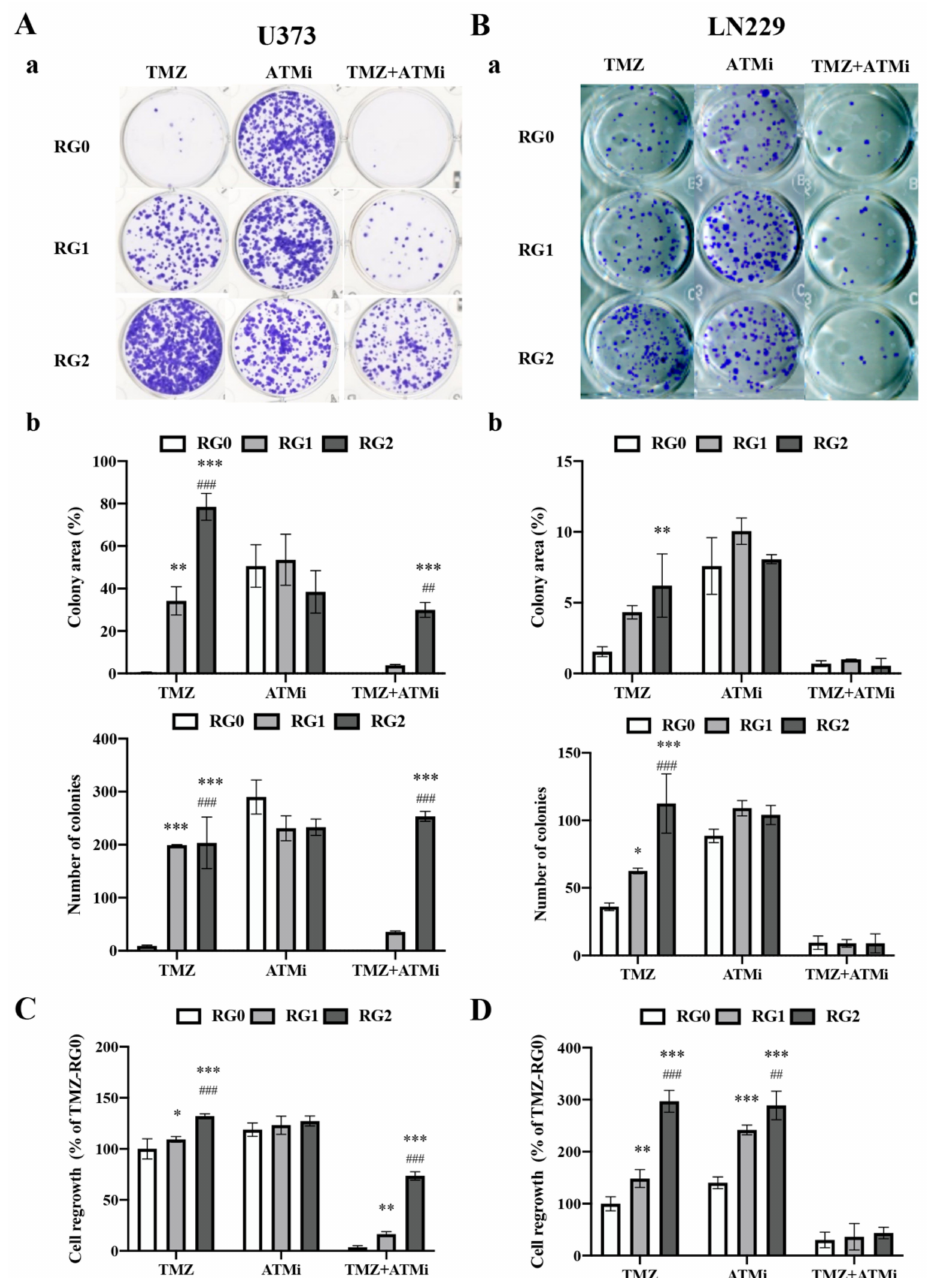
Figure 3. RG2 cells display a remarkable clonogenic growth accompanied by higher proliferation activity in the post-treatment phase. U373 RG cells and LN229 RG cells received treatment with TMZ (150 µ M), ATMi (KU-60019, 10 µ M), or TMZ+ATMi for 72 h. After the treatment, viable cells were reseeded in a 12-well plate for colony formation assay or in a 96-well plate for proliferation assay. ( A , B ) Colony formation assay. After incubation of reseeded U373-RG cells ( A ) and LN229 RG cells ( B ) for 11 d and 7 d, respectively, cells were stained with 0.5% crystal violet for analysis of the number- and the total area of colonies using the ImageJ software (version 1.53q). ( A-a , B-a ): Representative images showing colonies grown in different groups of U373 RGs and LN229-RGs, respectively. ( A-b , B-b ): Quantitative analysis of the area and the number of colonies in U373 RGs and LN229-RGs, respectively. ( C , D ) Regrowth of RG cells. MTT assay was performed on day 11 and day 7 of post-treatment in TMZ-treated U373-RGs and LN229 RGs, respectively. *, p < 0.05; **, p < 0.01; ***, p < 0.001, compared with RG0. ##, p < 0.01; ###, p < 0.001, compared with